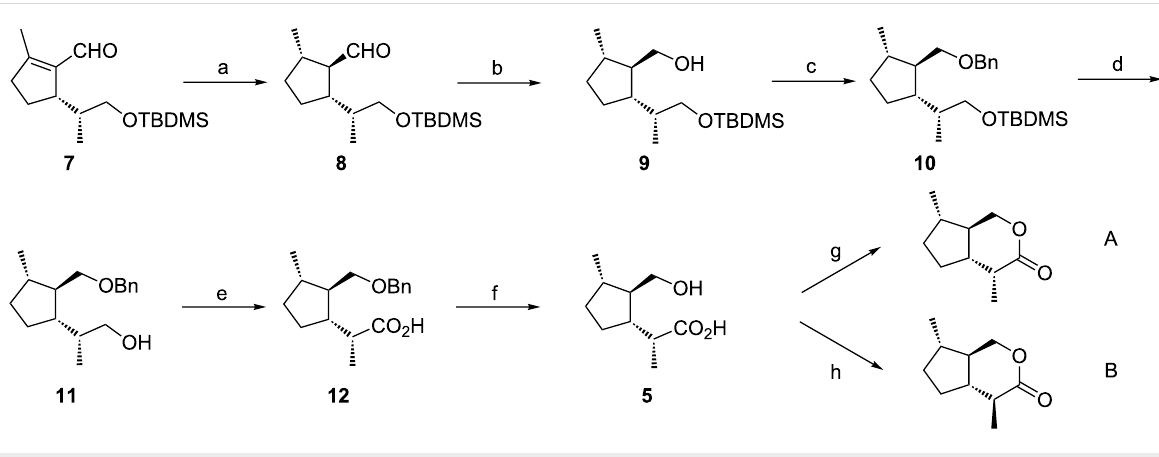
Scheme 1: Synthesis of the trans -fused iridomyrmecins A and B . Reaction conditions and yields: a) ammonium formate, Pd/C, MeOH, reflux (48%); b) NaBH 4 , MeOH, H 2 O, rt (79%); c) NaH, BnBr, THF, reflux (96%); d) HF, CH 3 CN, rt (71%); e) CrO 3 , H 2 SO 4 , acetone, rt (99%); f) Pd/C, 40 bar H 2 , THF, rt (100%); g) DCC, DMAP, CH 2 Cl 2 , rt (66%); h) p -TsOH, benzene, reflux